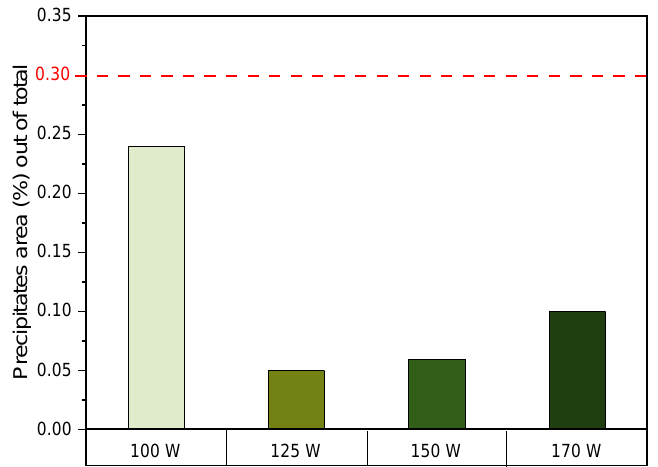
Figure 11. Percentage of the analysed area covered by precipitates.